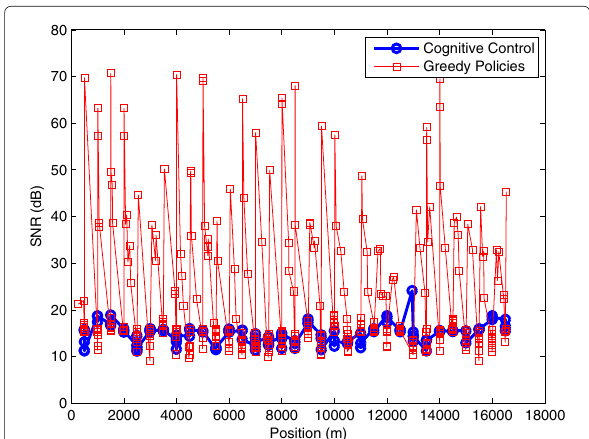
Fig. 16 SNR levels handoffs happen under different